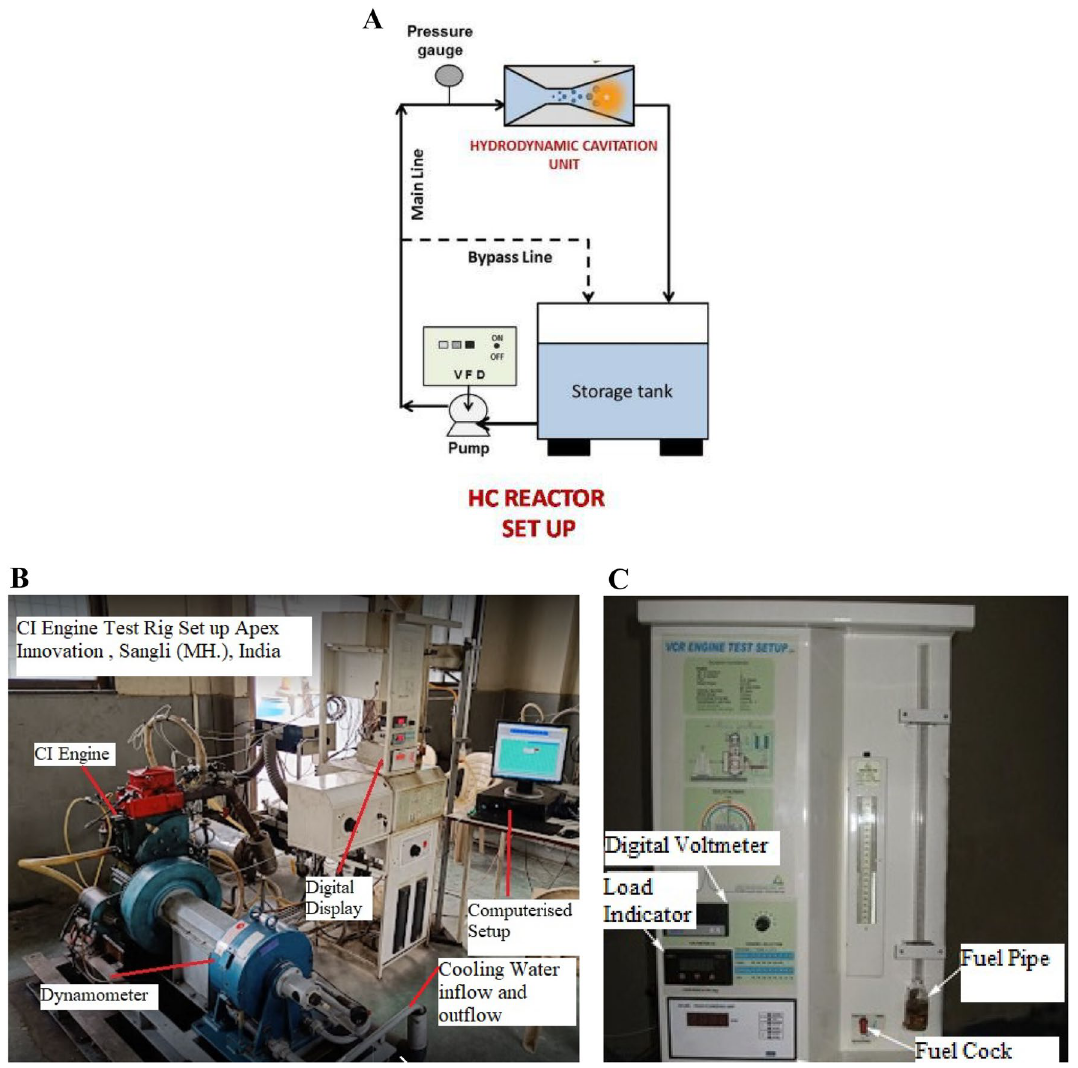
Fig. 1 a Cavitation reactor based on hydrodynamic principle (Reprinted with permission from Ref. [37] Copyright 2020 MDPI). b Computer- ized four-stroke diesel engine. c Front Panel of four-stroke diesel engine